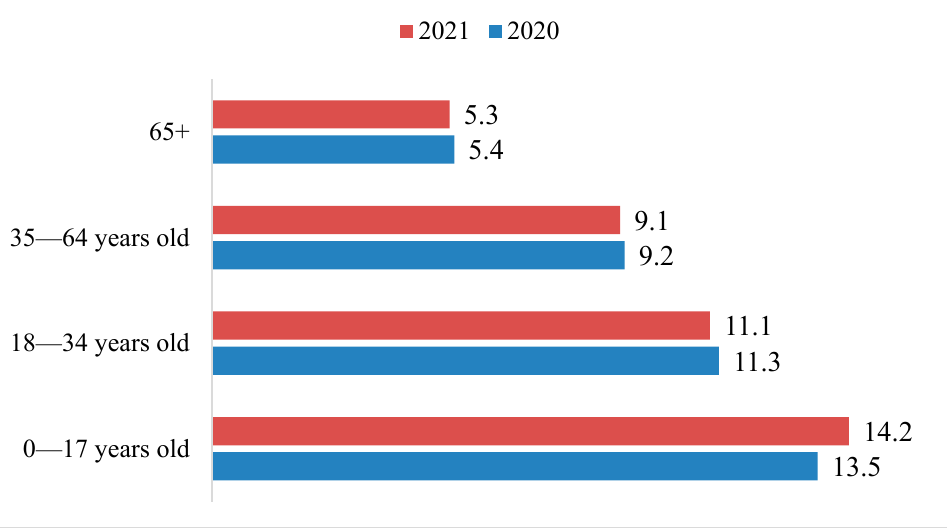
Figure 3. Poverty rate trends, by age, 2020–2021. Source: own elaboration on the Istat database.